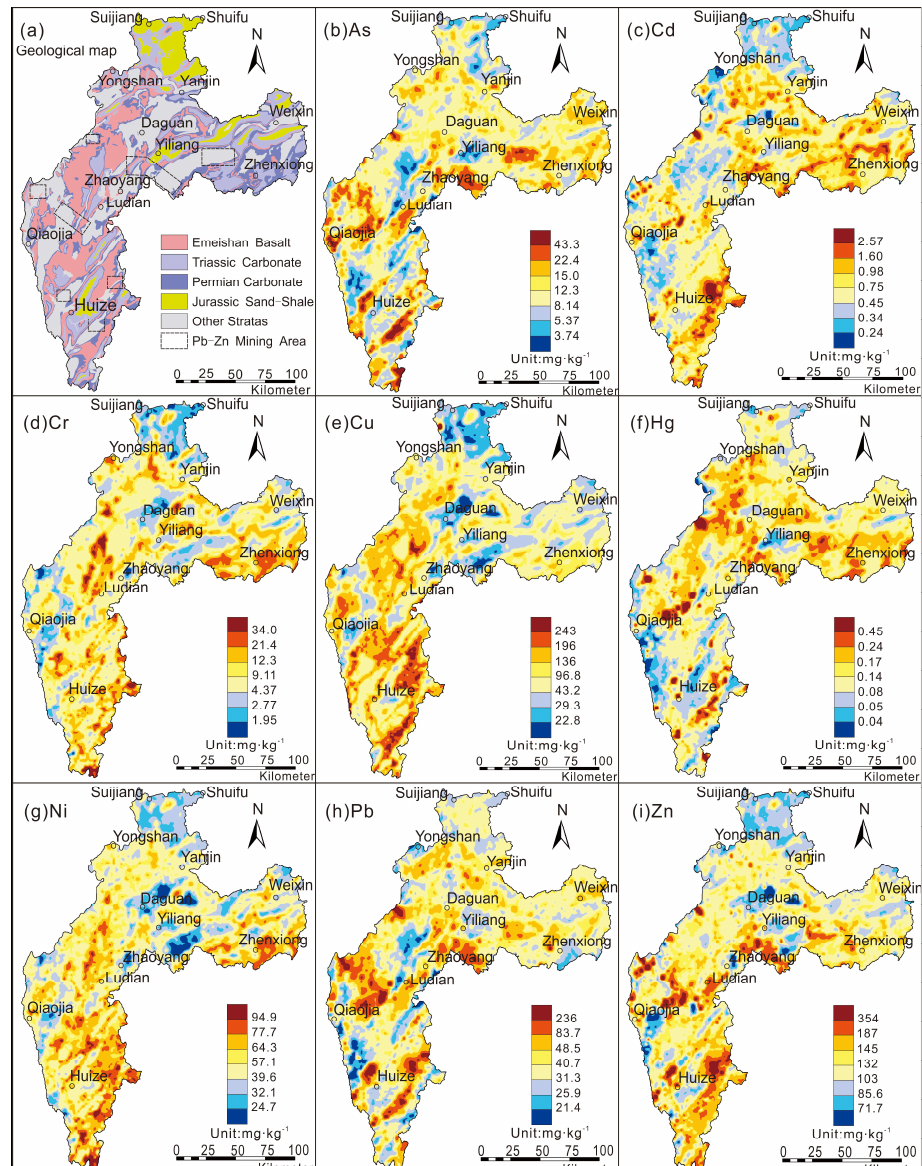
Figure 2. Spatial distribution of heavy metal concentrations in the study area. ( a ) geological map, ( b ) As, ( c ) Cd, ( d ) Cr, ( e ) Cu, ( f ) Hg, ( g ) Ni, ( h ) Pb, ( i ) Zn.